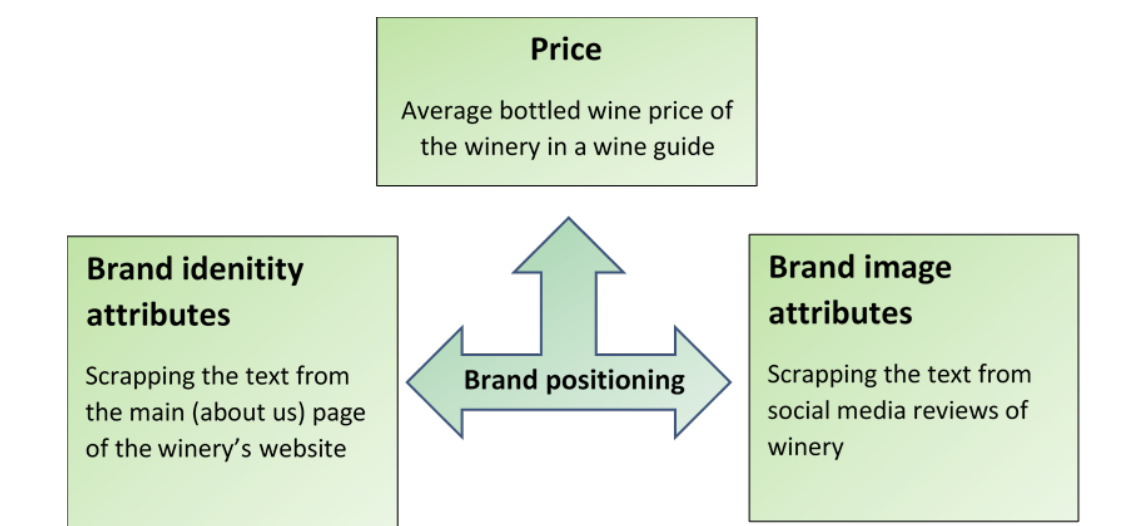
Figure 1. Sources of data deployed in the study: wine guide, website, online review.